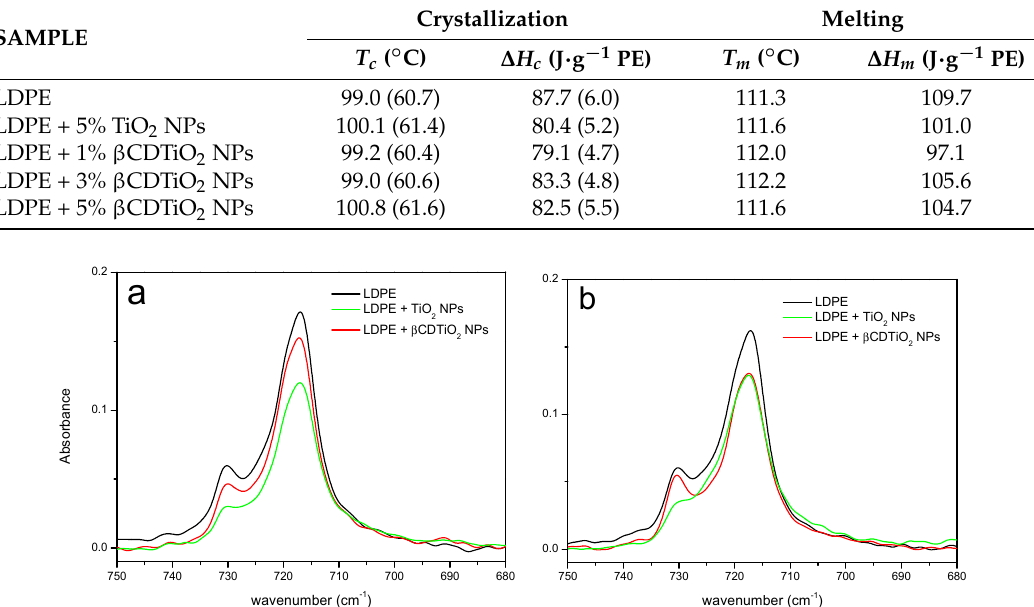
Table 1. Crystallization and melting (peak) temperatures and enthalpies of LDPE and its mixtures with 5% TiO 2 NPs and 1%, 3% and 5% β CDTiO 2 NPs (values between parentheses correspond to a secondary crystallization peak).